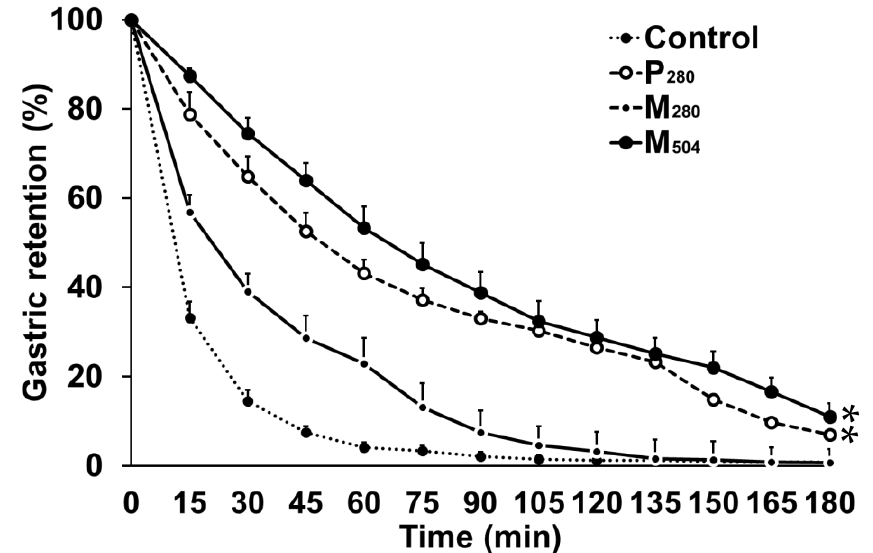
Figure 1. Intra-gastric retention (%; n = 11 healthy young men) of a control drink (450 mL; ~2 kcal/‘control’) or iso-volumetric drinks containing protein/carbohydrate/fat: (i) 14g/28 g/12.4 g (280 kcal/‘M 280 ′), (ii) 70 g/28 g/12.4 g(504kcal/‘M 504 ′), or (iii) 70 g/0 g/0 g(280 kcal/‘P 280 ′). Effects of drink-condition were determined by repeated-measures ANOVA with post hoc Bonferroni corrections. * P < 0.05, post hoc tests: P 280 and M 504 gastric emptying was slower than M 280 and control. Data presented as mean (± standard error of mean (SEM)).